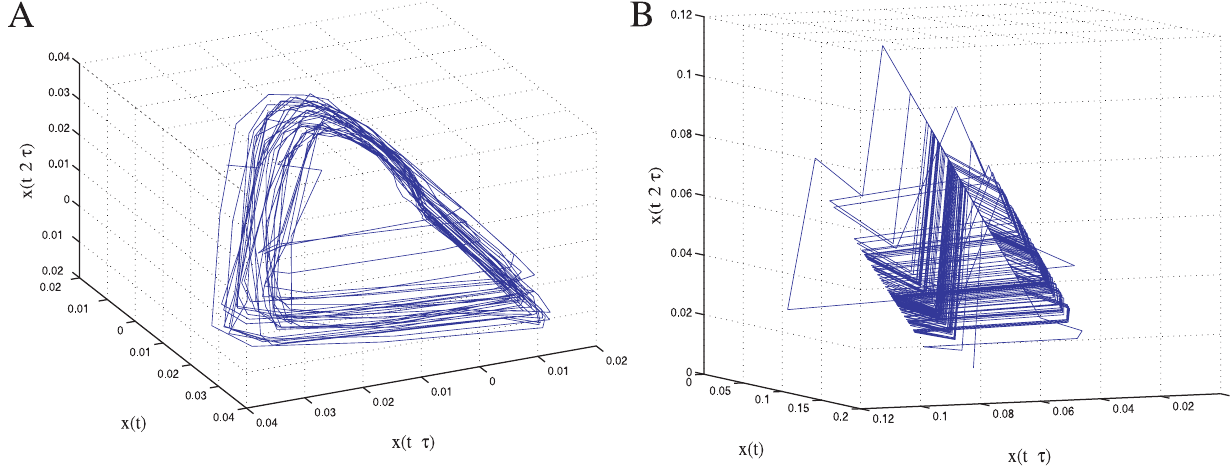
Figure 2. Three dimensional embeddings of a time series of fluorescence ratios (Nod1) and the stochastic spiking model data for comparison. A: The experimental series is clearly noisy, prohibiting accurate dimensionality determination, but it unfolds well to the eye in three dimensions. B: The data from the stochastic spiking model, however, appears to cross itself in many places and coalesces, violating the uniqueness property of ODE.